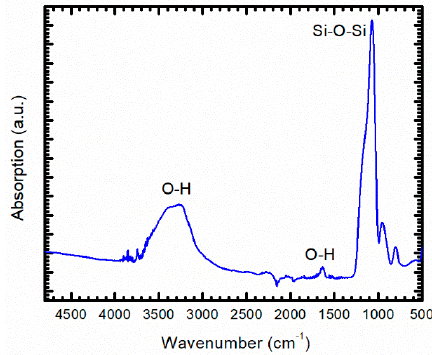
Figure 4. FTIR spectra of the coating.